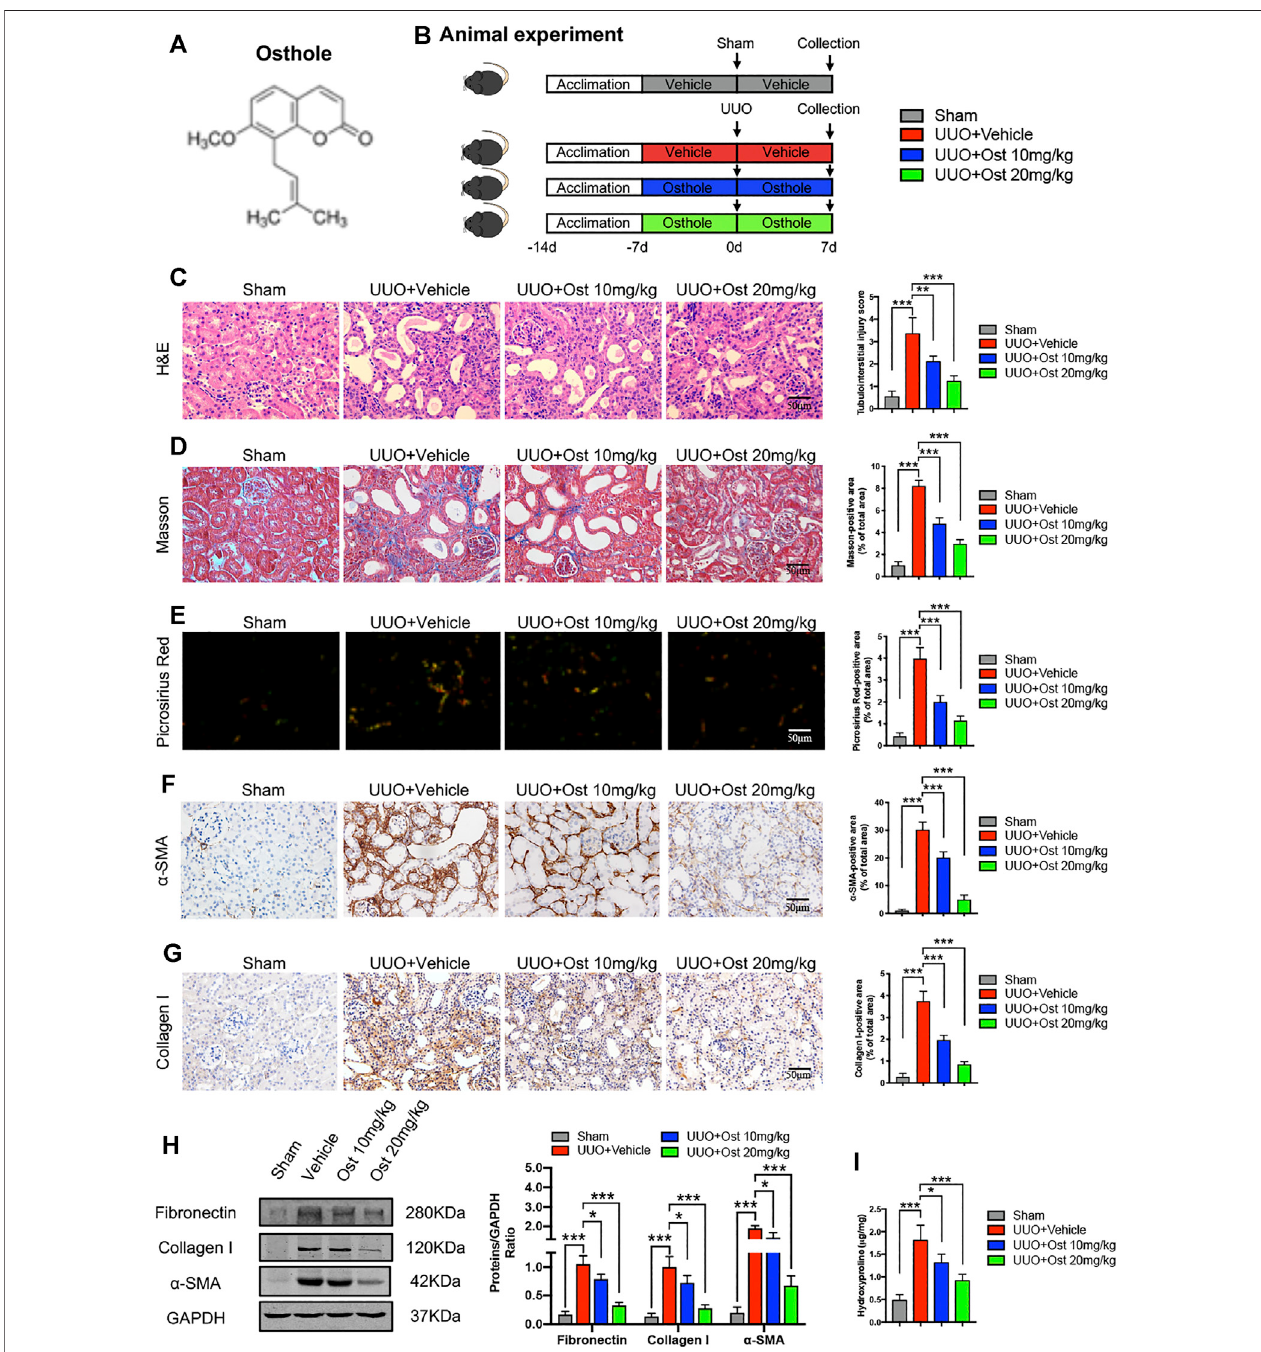
FIGURE 1 | Osthole ameliorates UUO-induced renal pathological damage and renal fi brosis in vivo. (A) Chemical structure of osthole. (B) Animal experimental protocolofthisstudy. (C) Representativekidney H&Estainingofdifferent groups; thequanti fi cation oftubulointerstitial injuryscore. Scalebar,50 μ m. ( n (cid:1) 6mice/group) (D) Representative kidney Masson ’ s trichrome staining of different groups; the quanti fi cation of Masson ’ s trichrome staining. Scale bar, 50 μ m. ( n (cid:1) 6 mice/group) (E) Representative kidney Picrosirius Red staining of different groups; the quanti fi cation of Picrosirius Red staining. Scale bar, 50 μ m. ( n (cid:1) 6 mice/group) (F) Representative immunohistochemistry staining for α -SMA; the quanti fi cation of α -SMA immunohistochemistry staining. Scale bar, 50 μ m. ( n (cid:1) 6 mice/group) (G) Representative immunohistochemistry staining for collagen I; the quanti fi cation of collagen I immunohistochemistry staining. Scale bar, 50 μ m. ( n (cid:1) 6 mice/group). (H) Representative western blots for α -SMA, collagen I and fi bronectin protein expressions in kidney; the quanti fi cation of α -SMA, collagen I and fi bronectin western blots. ( n (cid:1) 6 mice/group) (I) Kidney hydroxyproline level of different groups. ( n (cid:1) 6 mice/group). All data are presented as means ± SD. * p < 0.05, ** p < 0.01, *** p < 0.001.